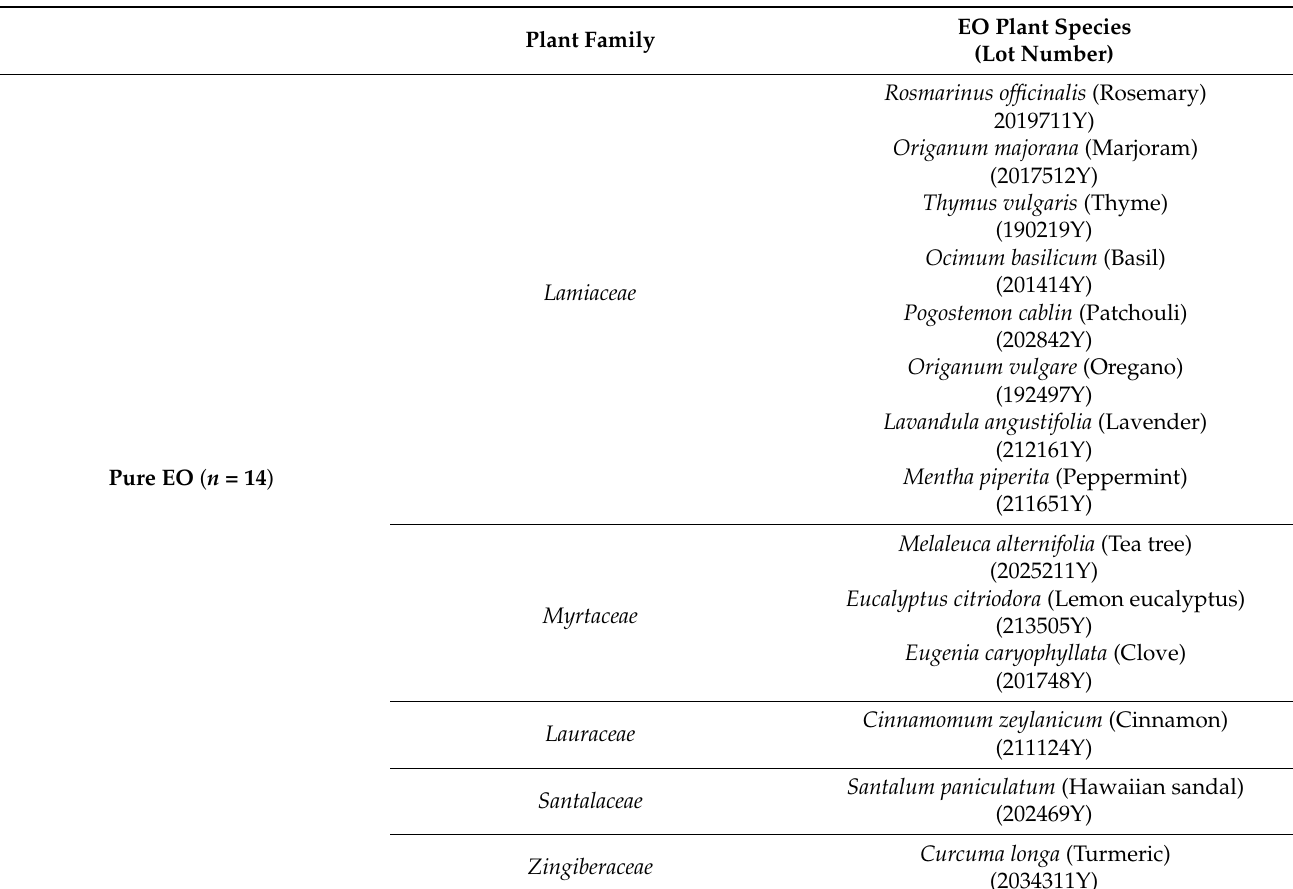
Table 3. List of EO tested for anti- Pseudomonas activity. Plant